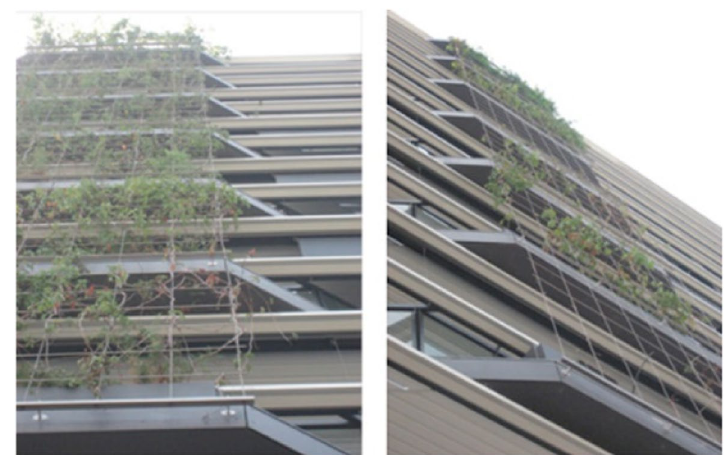
Fig. 2 The system of cables and wiring for the climbing plant [14]. The two systems use high-tensile steel cables and related equipment. The wiring system is more flexible than the cable system and allows for greater design space. It may be adjusted in both vertical and horizontal dimensions to accommodate an endless number of different sizes and styles